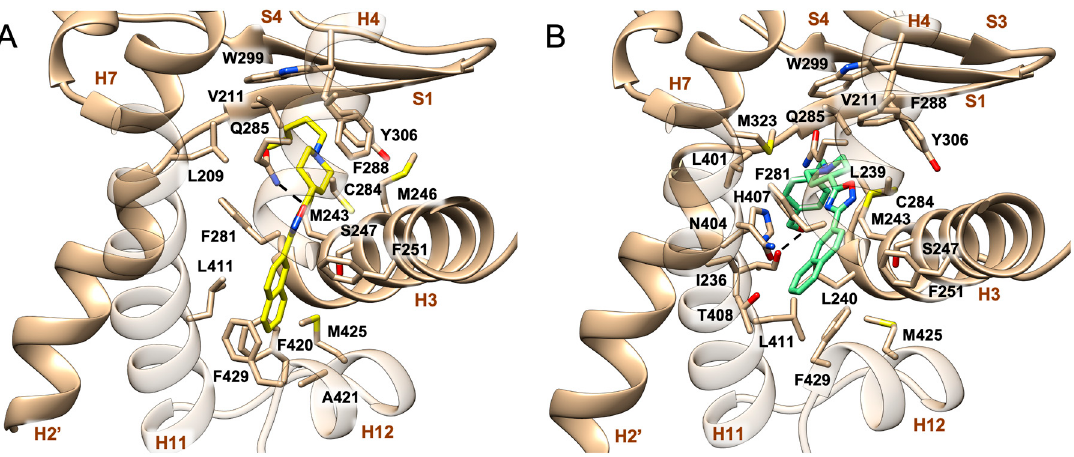
Figure 3. Binding modes of ( A ) compound 5 (in yellow sticks) in the X-ray structure of PXR-LBD (PDB ID 7AXE) and ( B ) compound 11 (in light green sticks) were observed in the X-ray structure of PXR-LBD (PDB ID 3HVL) [34]. PXR is shown as tan cartoon, while the interacting residues of the receptors are shown in tan sticks. Hydrogens are omitted for clarity. Hydrogen bonds are shown as dashed black lines.